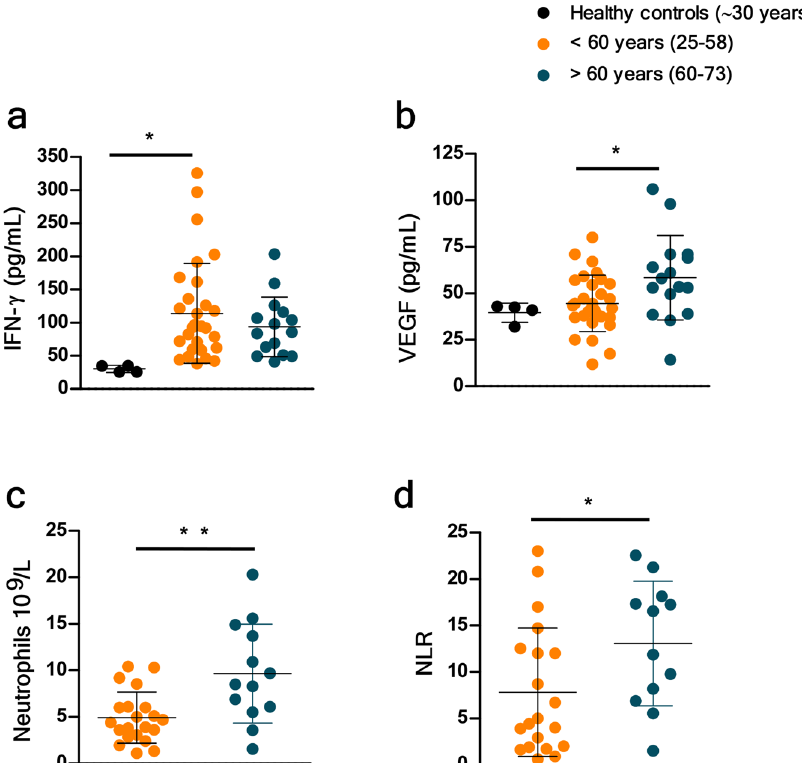
Fig. 8 VEGF and peripheral neutrophil counts are higher in old COVID-19 patients. Peripheral blood samples were obtained from a cohort of patients with laboratory-con fi rmed SARS-CoV-2 infection at hospital admission. Levels of different immune markers were determined by Luminex assay in plasma samples from COVID-19 and healthy volunteer controls. COVID-19 patients were strati fi ed by age as younger than or older than 60 years. a Levels of IFN- γ and b levels of VEGF proteins were measured in plasma of COVID-19 and healthy controls. c Peripheral neutrophil counts and d neutrophil to lymphocyte ratio (NLR) values were retrieved from the medical records of COVID-19 patients and compared between age groups. Each point in the fi gure corresponds to an independent biological sample for each group. Mean± SD for each group is shown in the fi gure. Statistical signi fi cance was veri fi ed by one-way anova: P = *(<0.05), **(<0.01) with Tukey ’ s correction ( a and b ) or by Student ’ s t -test: P = *(<0.05), **(<0.01) ( c and d